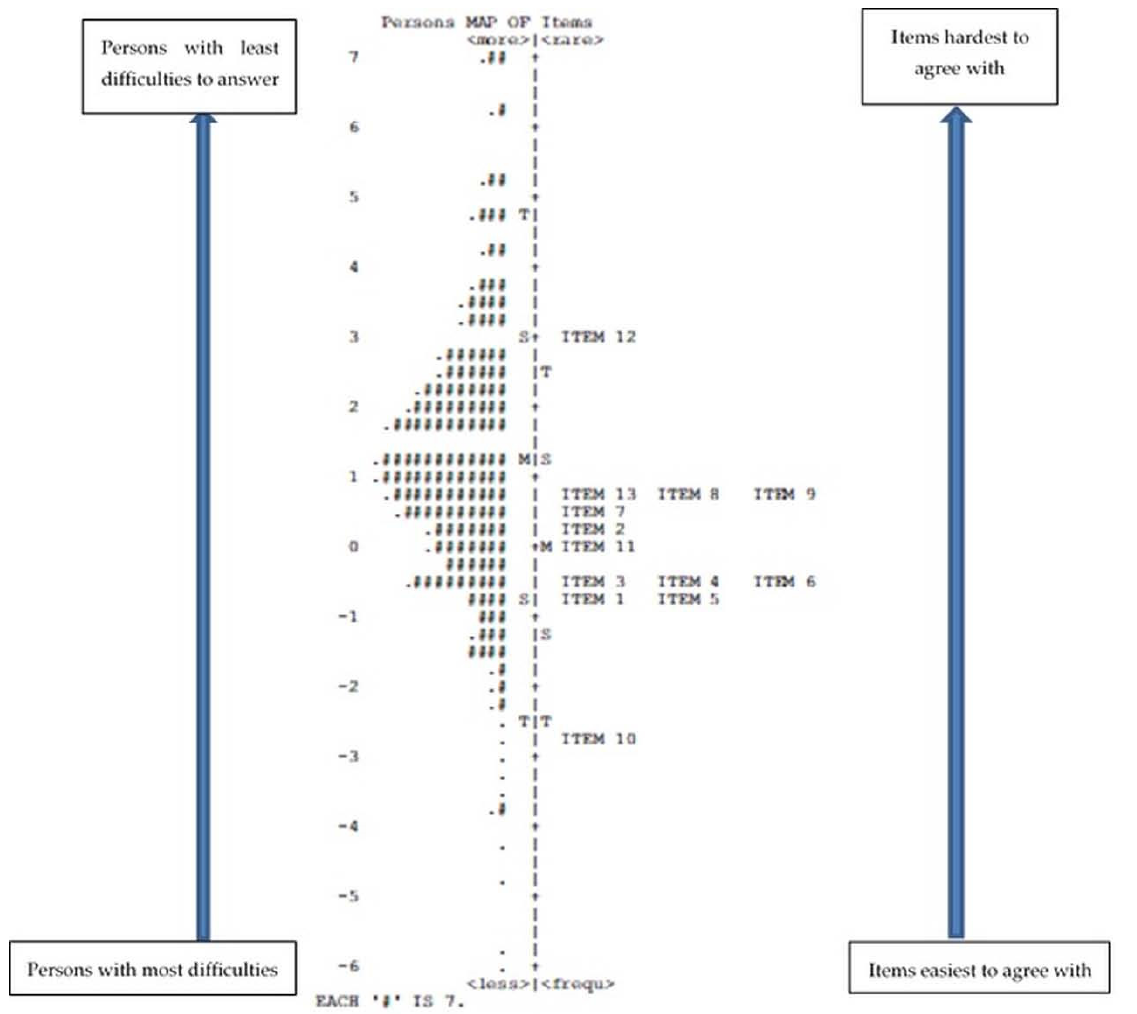
Figure 1. Person–item map of the adapted IPC scale. Notes: The line running vertically in the middle of the map divides the map into two halves. The left side shows the person measures, and the right side shows the item measures. The letters positioned on the ruler indicate the mean value (M), one standard deviation (S), and two standard deviations (T) for the persons and the 13 items of the IPC scale. The map allows us to evaluate how well the 13 items are distributed regarding the agreement level toward interprofessional collaboration. This evaluation is based on the distance between the mean item measure (“M” on the right side of the Wright map) and the mean person measure (“M” on the left side of the Wright map). The higher a person’s value is on the vertical line, the less difficulty they had agreeing with the item, while persons at the bottom had the greatest difficulty [21].